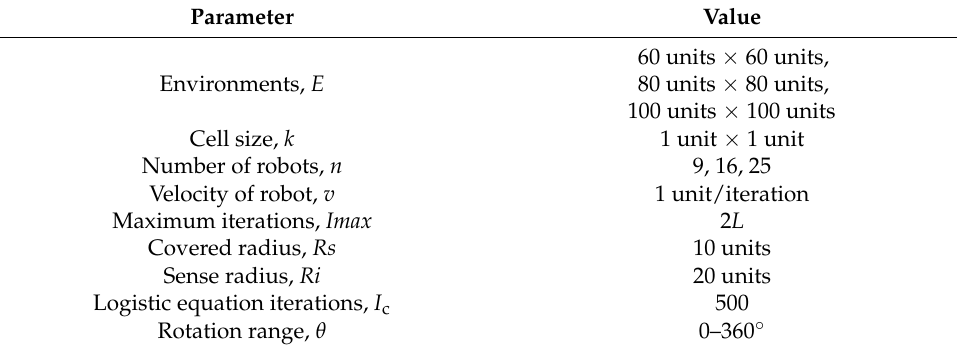
Table 2. Parameter settings of the swarm robotic